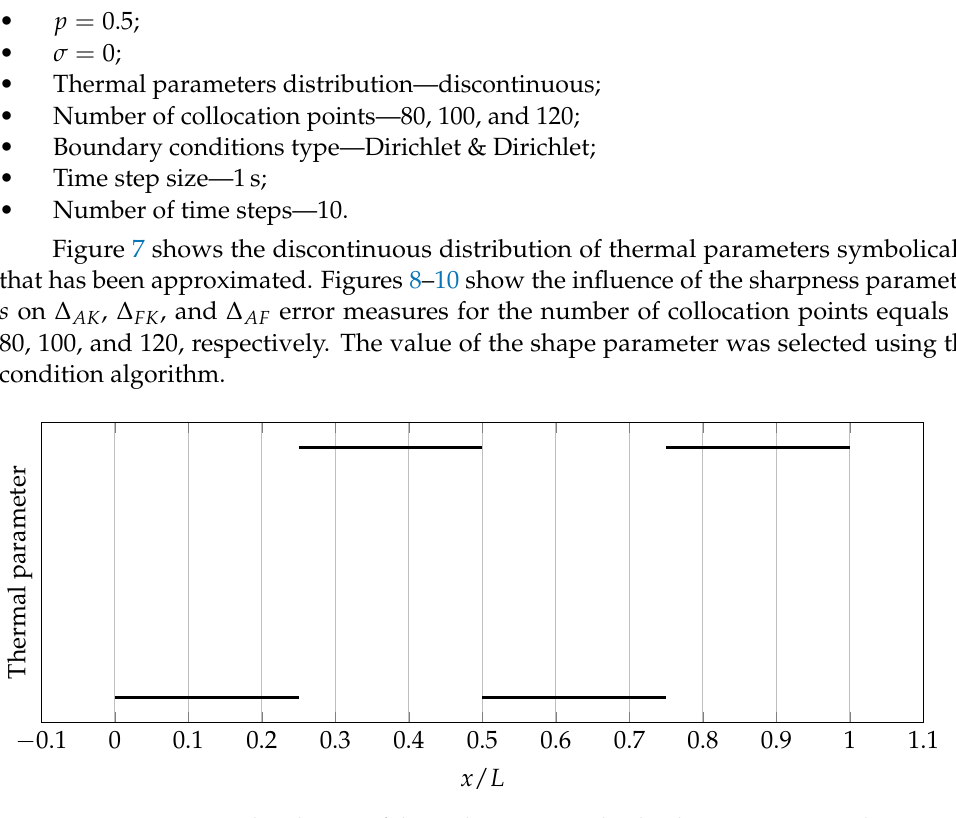
Figure 7. Discontinuous distribution of thermal parameters that has been